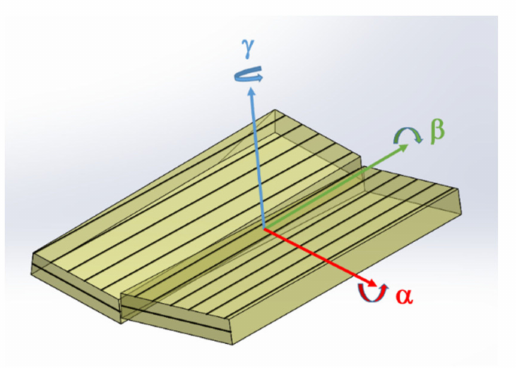
Figure 14. Scheme of tiling technology: combining two crystals to get a one larger; three important misorientation angles α , β , and γ are marked. A mutual misorientation of the seeds in three planes allows obtaining crystals in which the angular differences of α , β and γ are smaller than the variation of crystal